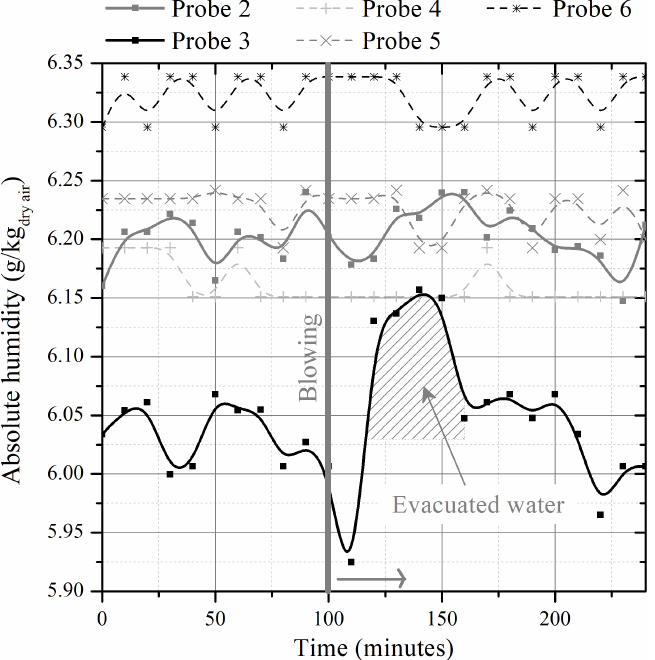
Figure 14. Evolution of absolute humidity in the wet wall during ventilation of the air